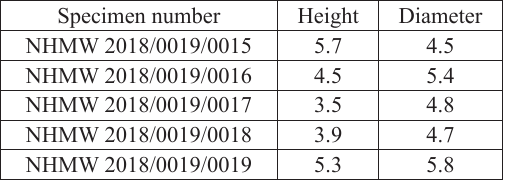
Table 3. Measurements (in mm) of Valvata koehleri sp.